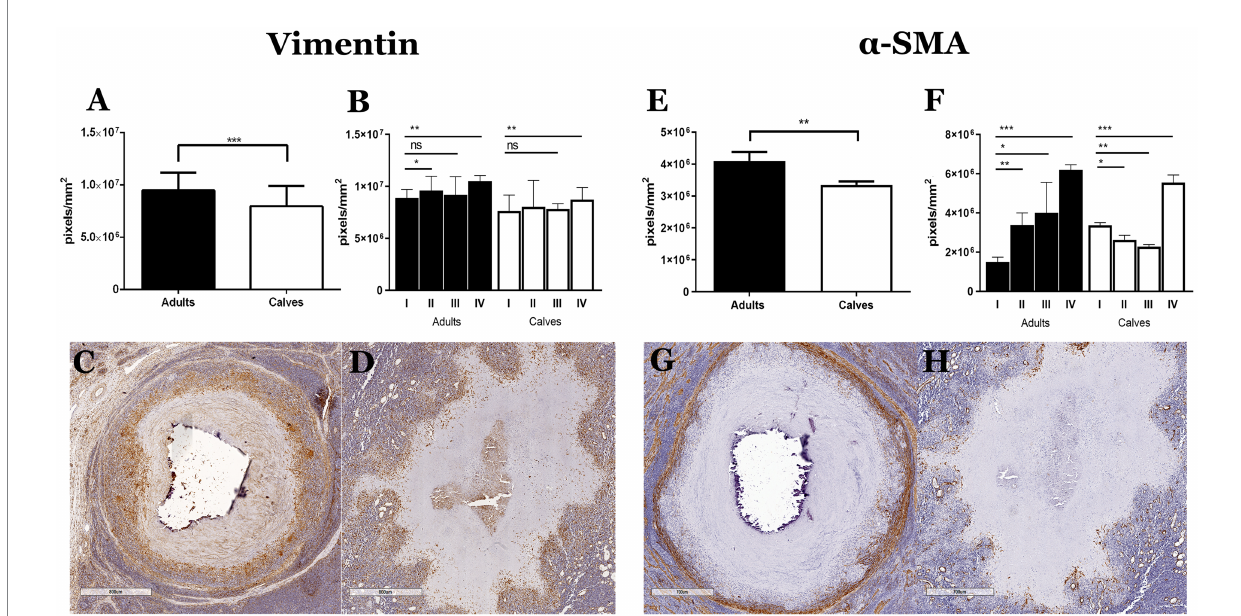
FIGURE 2 Absence of connective tissue capsule in granulomas of calves naturally infected by Mycobacterium bovis is associated with a lower number of fibroblasts and myofibroblasts. (A,B and E,F) Expression of vimentin and α -SMA immunolabeling was quantified in the granulomas and stages of adults and calves, Mann–Whitney test * p < 0.05, ** p < 0.01, and *** p < 0.001, respectively. (C,D) IHCs of vimentin in late granulomas show abundant staining mainly in the connective tissue capsule of granuloma from adult cattle compare with calf granuloma, respectively. (G,H) IHCs of α -SMA in late granulomas show myofibroblast forming the connective tissue capsule in granuloma from adult cattle. However, granuloma from a calf showing mixed positive cells around the necrosis without forming a connective tissue